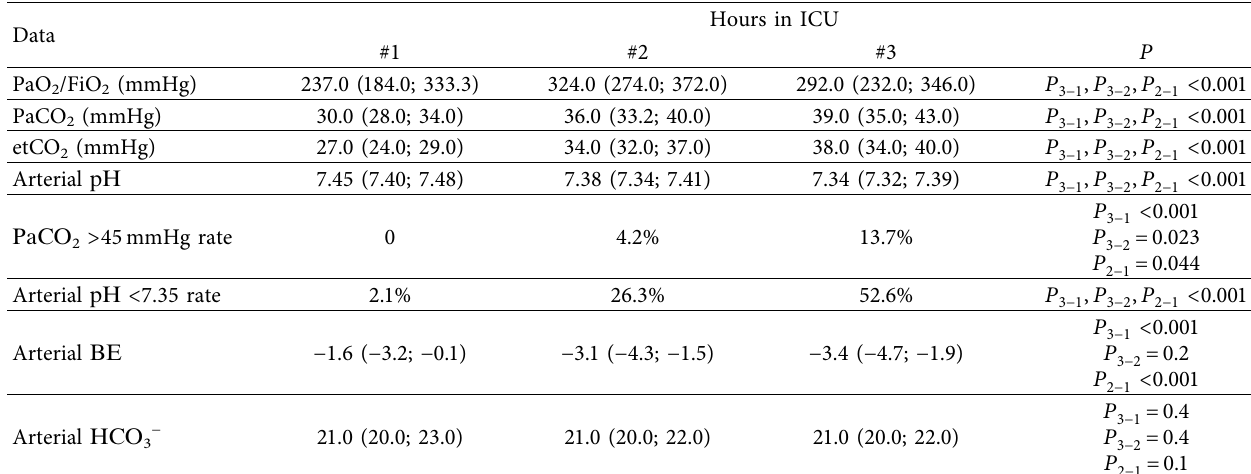
Table 2: Changes in oxygenation, elimination of CO 2 , and acid-base balance of arterial blood in patients from the interventional group, median (25 th ; 75 th percentile), n �